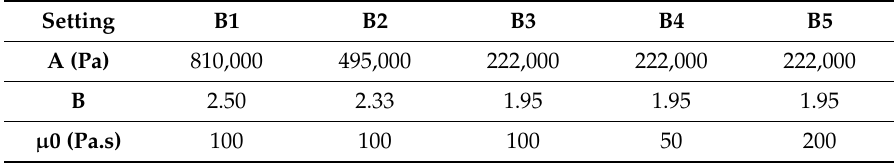
Table 2. Parameter settings used for the Bingham model in the simulations of the backwards facing step flow. Setting